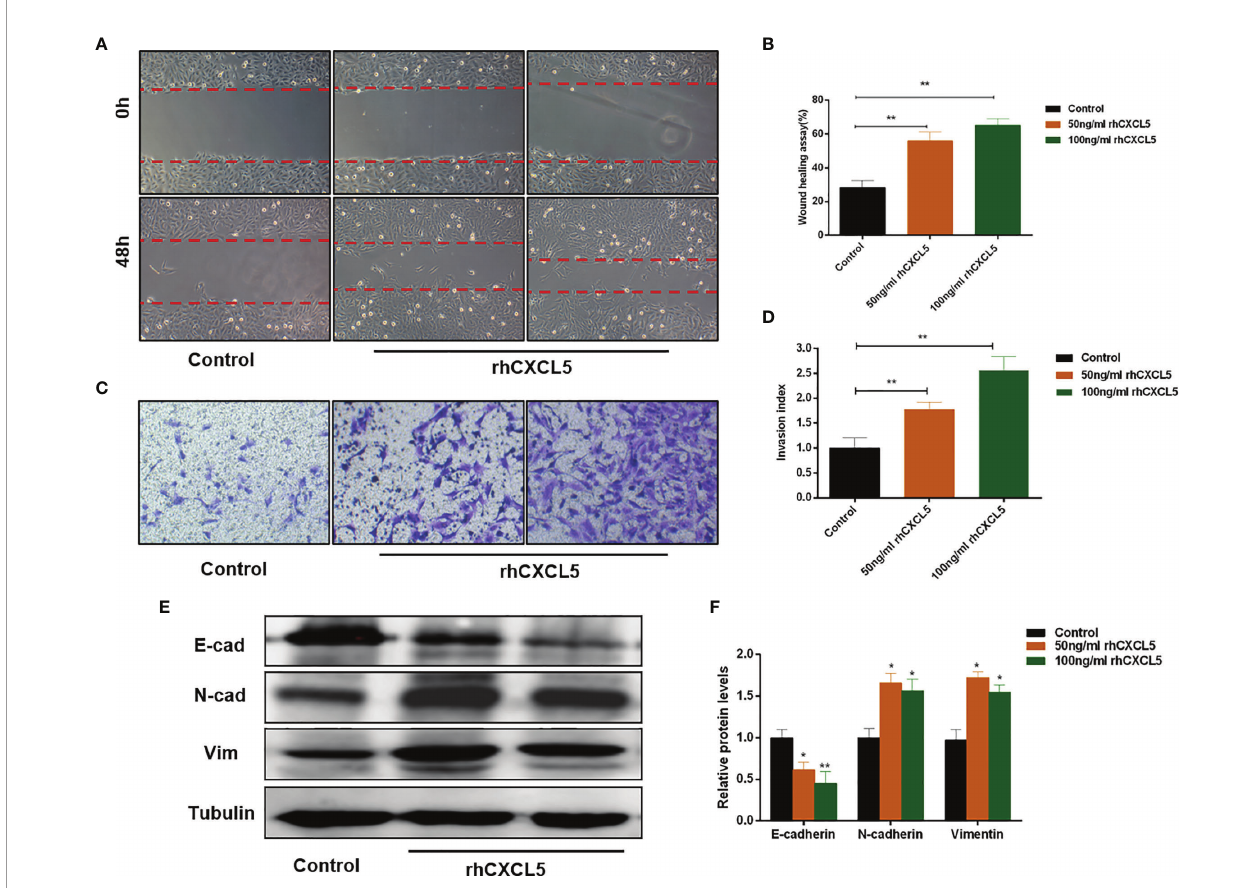
FIGURE 3 | CXCL5 induces the EMT process to promote trophoblast migration and invasion. HTR-8 cells were treated with 0, 50, and 100 ng/ml of rhCXCL5 for 48 h. (A, B) Scratch wound healing assay and quantitation were performed to examine trophoblast migration ability. (C, D) Matrigel invasion assay and quantitation were used to detect trophoblast invasiveness ability. (E, F) Western blotting and quantitation were determined to examine the expression levels of E-cadherin, N- cadherin, and vimentin. Representative images of migratory and invasive cells are presented. Data are presented as the mean ± SD. Results are reported as fold change compared with the control group (* p < 0.05, ** p < 0.01). rhCXCL5, recombinant CXCL5; EMT, epithelial-to-mesenchymal transition; E-cad, E-cadherin; N- cad, N-cadherin; Vim,